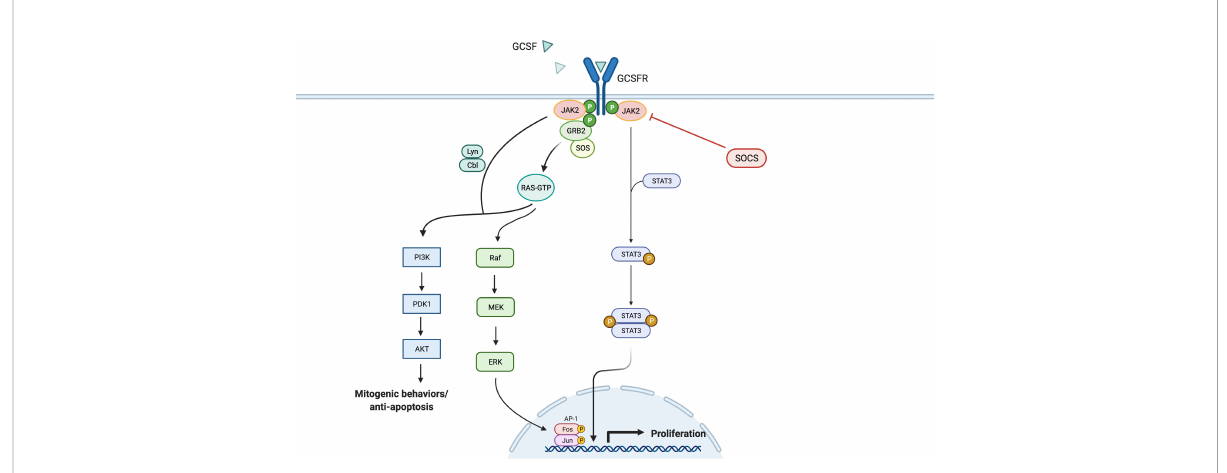
FIGURE 2 General Overview of GCSFR Signal Pathways. Adapted from “ Hippo Pathway in Mammals ” , by BioRender.com (2022). Retrieved from https://app.